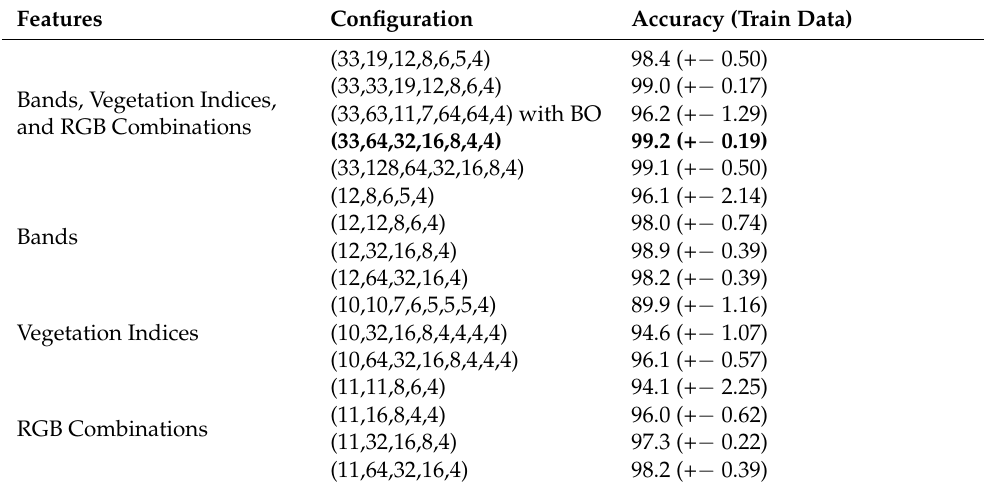
Table 5. Evaluation of neural network models for different numbers of neurons in the hidden layers.